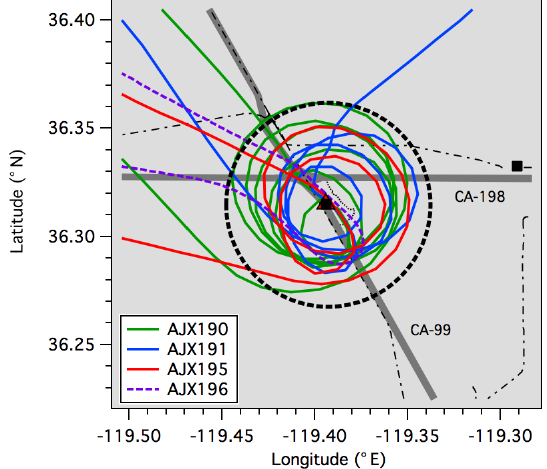
Figure 12. AJAX flight tracks in the vicinity of the VMA (red tri- angle with a black square). The lone black square represents the Visalia–N. Church St. O 3 monitor and the dashed black circle marks the 5km radius window used for the profile comparisons. The heavy gray lines show the major highways and the black dotted–dashed lines the